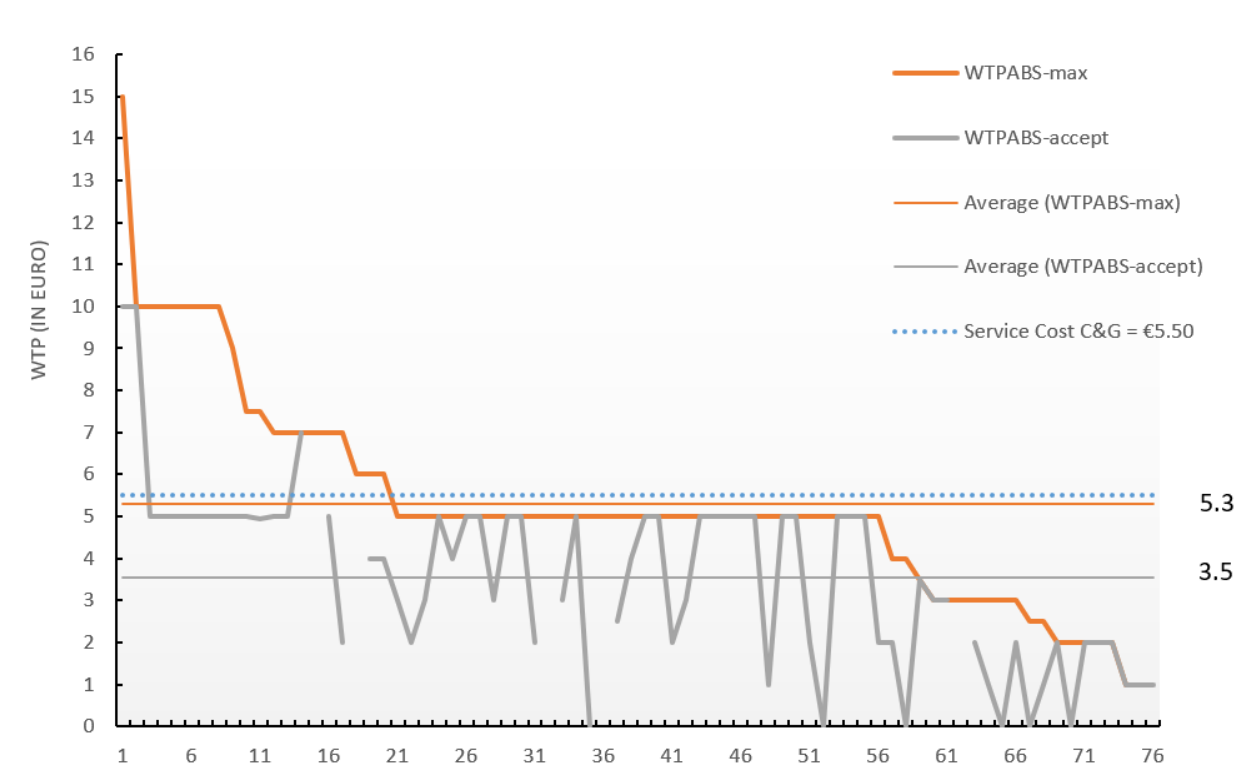
Figure 2. WTPABS for the non-users with a willingness to use, in descending order. Turning to the users of click-and-collect services ( n = 98; see Figure 3), their maximum WTP—the service cost at which they would stop—ranges between EUR 2.5 and 20, with an average of EUR 10.8 (SD = EUR 4.3). The modus is EUR 10. On average, the users would change their behavior at a fee of EUR 8.1 (SD = EUR 3.3). The range of the critical price point is between EUR 2 and 20, and the modus is again EUR 10. For more than one fifth of the respondents (22 cases or 22.4%), the two price points coincide. These users would thus continue to order groceries online with the same frequency until a certain point, after which they would stop completely. Overall, the difference between the two price points is EUR 2.8 (EUR 3.6 when omitting the differences of zero). Figure 3 also shows that the differences are larger when the maximum WTP is above the average of EUR 10.8. Note that a few respondents indicated fees below EUR 5.50, which, at first sight, is odd as these respondents would seem to have a lower maximum WTP or critical price point than the fee they are paying. However, for users of services other than Collect & Go the fees are lower. Moreover, the fee for Collect & Go used to be EUR 4.50 until 2011 and then changed to EUR 5.50. The Collect & Go users who indicated EUR 5 might not know exactly what the service cost is, they only know that it is “around EUR